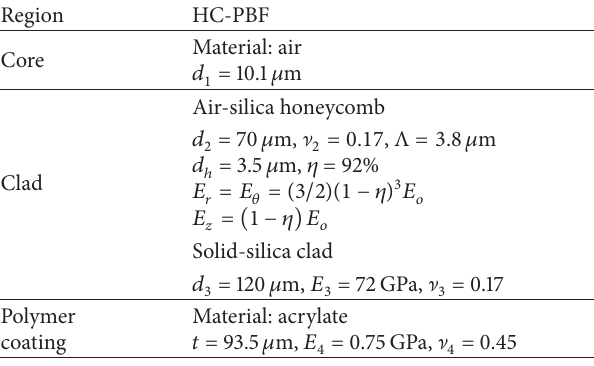
Table 1: Physical parameters of the investigated optical fiber [2, 6].